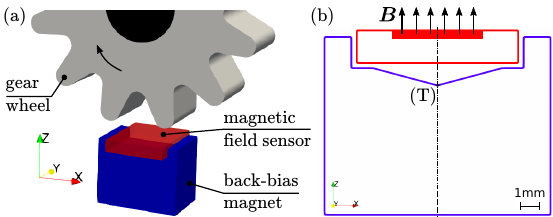
Figure 4. Magnetic wheel speed sensing. ( a ) Principle of the magnetic speed sensing. A permanent magnet is underneath the magnetic field sensor (back-bias magnet). A soft magnetic gear periodically modulates the bias field of the magnet. ( b ) Special back-bias magnet design for giant magnetoresistance (GMR)